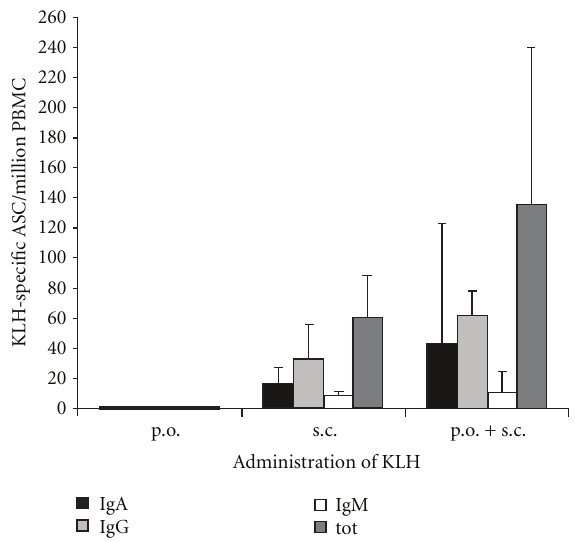
Figure 2: The numbers of KLH-specific plasmablasts identified with ELISPOT as KLH-specific antibody-secreting cells (ASC) in the circulation of vaccinees after oral KLH feeding ( n = 9) or after two subcutaneous KLH injections of nonprimed ( n = 5) or orally primed ( n = 9) volunteers. The data are given as geometric means of ASC/10 6 PBMC ± SEM.